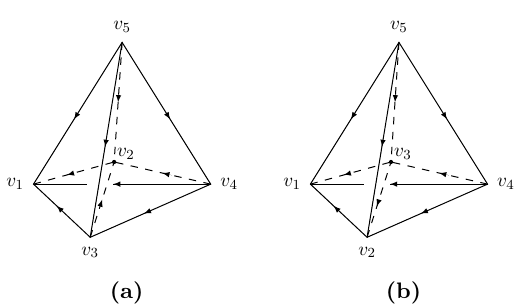
Figure 2. (a) The defining graph of the 4-cocycle [ v 1 v 2 v 3 v 4 v 5 ]. (b) Of [ v 1 v 2 v 3 v 4 v 5 ] − 1